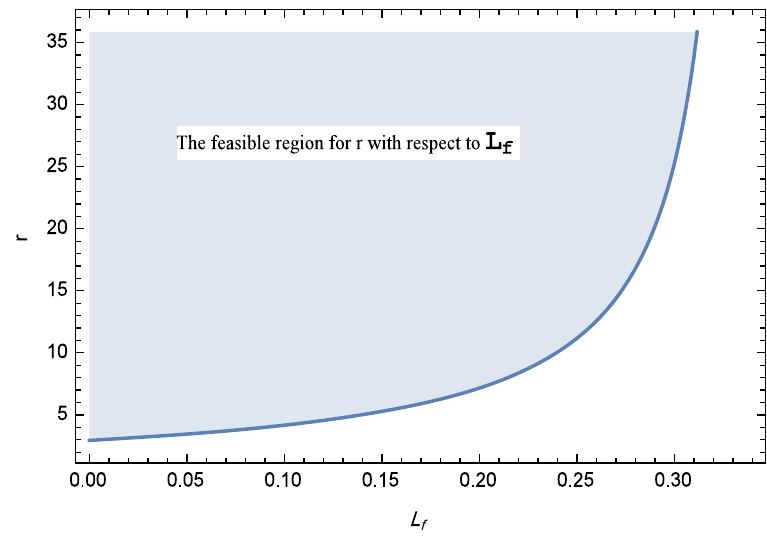
Figure 1: The feasible region for r with respect to L f in the interval 0, π 945